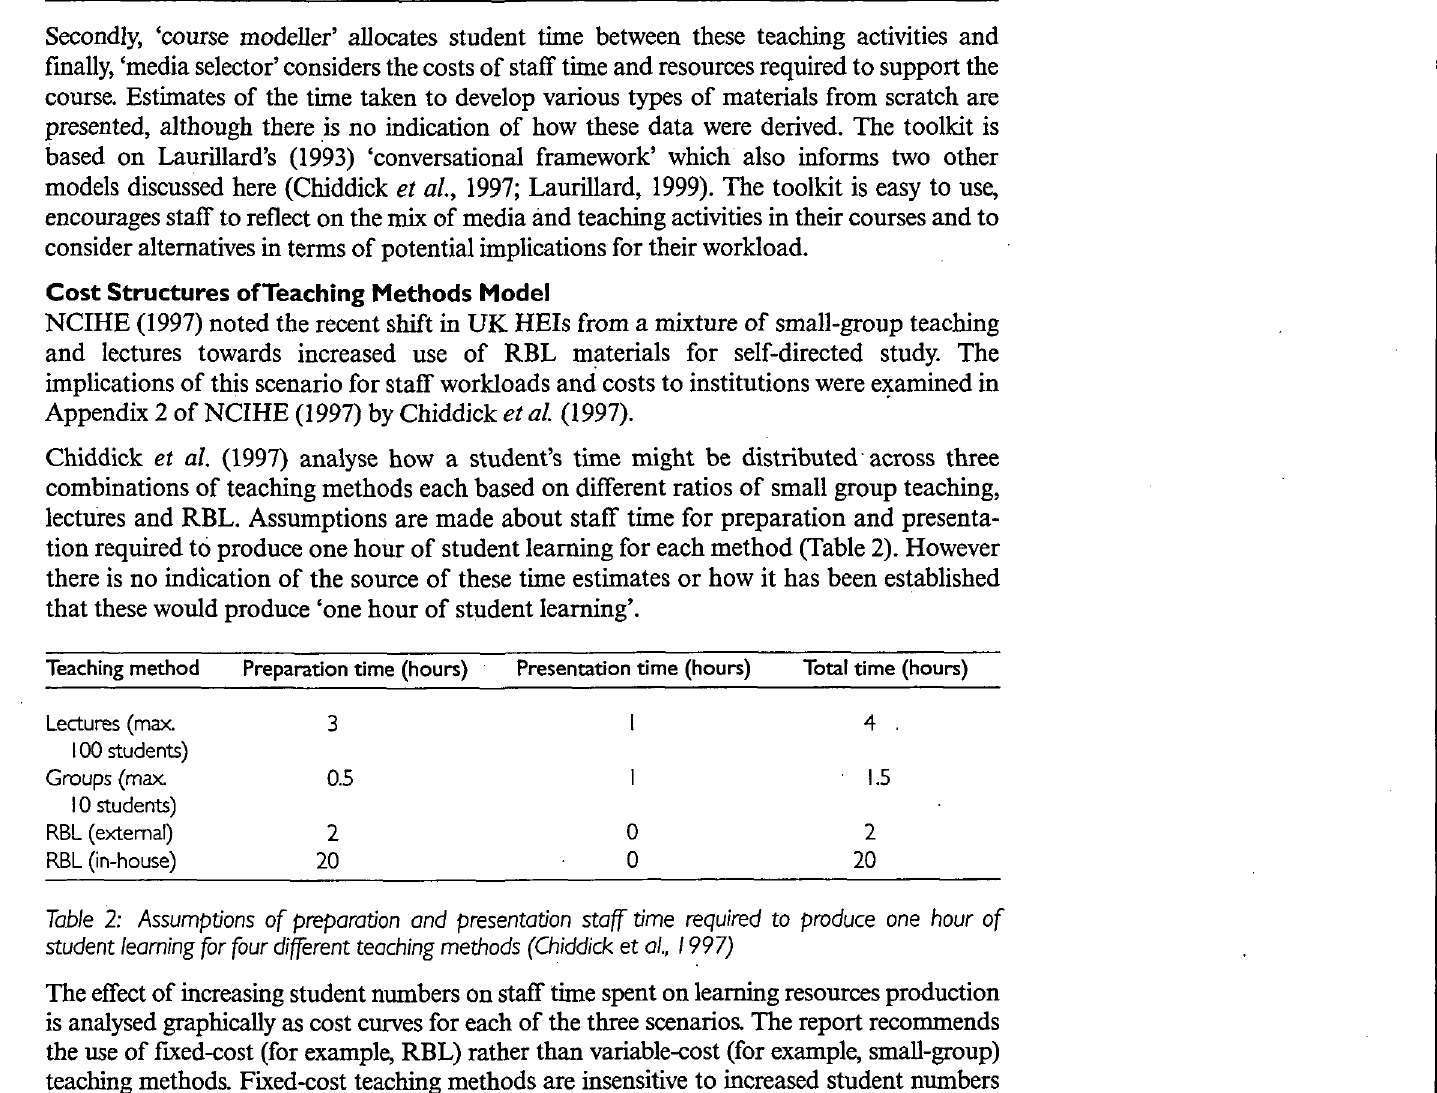
Table 3: Alternative combinations of teaching methods (Chiddick et al., 1997,Table